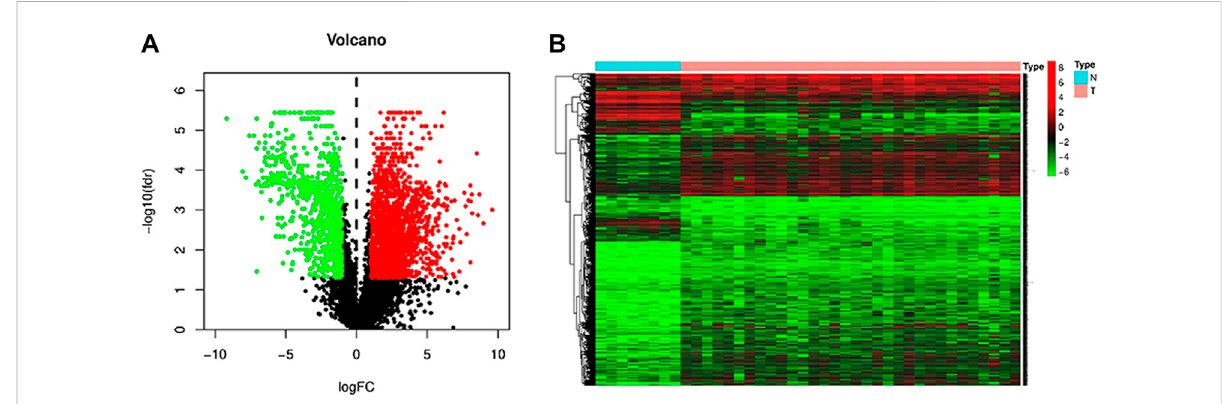
FIGURE 1 Differentially expressed lncRNAs in iCCA patients and adjacent normal patients. (A) Volcano map of differentially expressed lncRNAs (red dots represent up-regulated genes, green dots represent down-regulated genes). (B) Cluster heat map of hetero-expressed gene.